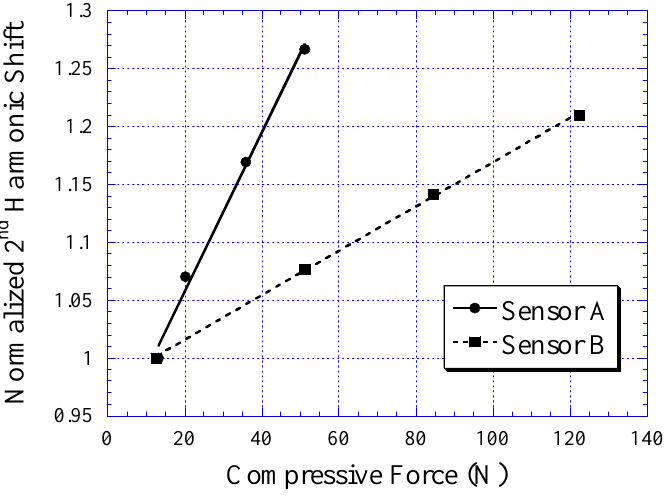
Figure 8. The response of Sensor A is repeatable and stable with cyclic stress